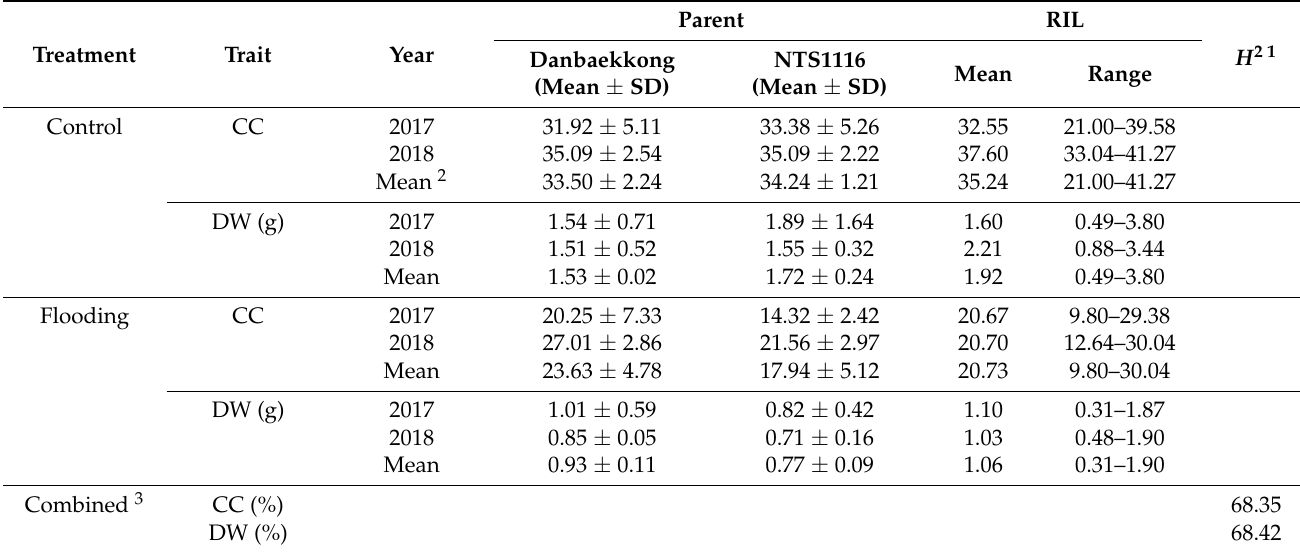
Table 1. Leaf chlorophyll content (CC) and shoot dry weight (DW) of parents (‘Danbaekkong’ and ‘NTS1116’) and recombinant inbred lines under control and flooding-stressed conditions over two years.